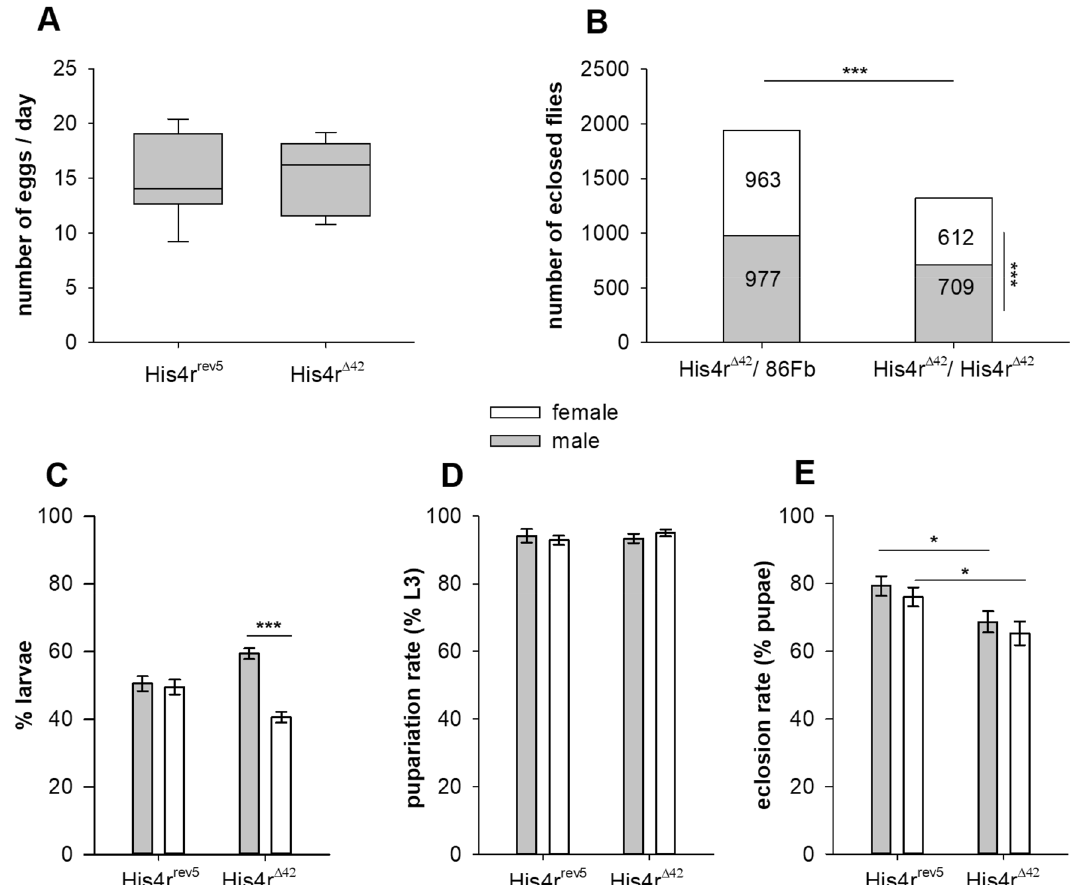
Figure 2. Loss of His4r reduces viability but does not affect fertility. (A) There was no significant difference in the fecundity of His4r Δ42 and His4r rev5 control females. Boxplot shows the distribution (first quartile, median, third quartile, and 10th and 90th percentiles as whiskers) of eggs laid by females daily, n = 5 females in 10 vials per each genotype. (B) The number of eclosed homozygous His4r Δ42 flies was significantly lower (P < 10 −6 , binomial test) than that of heterozygous control siblings and among homozygous His4r Δ42 progeny the number of females was significantly lower than that of males (P = 6.2 × 10 −4 , binomial test). (C) Among His4r Δ42 homozygous L3 larvae the ratio of females to males was significantly lower (P = 3 × 10 −10 , t-test) than among His4r rev5 controls. The bars show the percentage of male and female L3 larvae, error bars represent standard error, n = 20 vials per genotype. (D) The pupariation rate of His4r Δ42 homozygotes did not change compared to His4r rev5 controls. The bars show the percentage of pupariated L3 larvae, error bars represent standard error. (E) In His4r Δ42 homozygotes the eclosion rate of both male and female pupae were lower (P = 0.01 and P = 0.02, respectively, t-test) than that of the His4r rev5 controls. The bars show the percentage of eclosed pupae, error bars represent standard error. *P ≤ 0.05, ***P < 10 −3